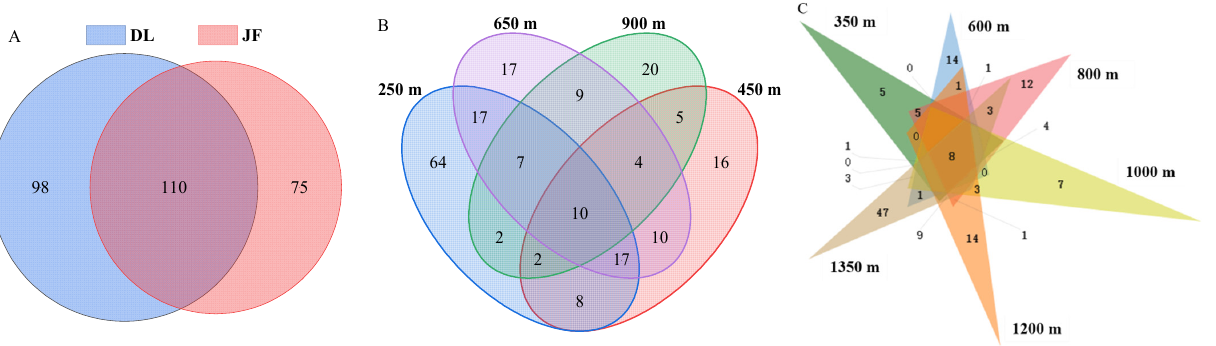
Figure 1. Venn diagrams showing the shared AMF OTUs between the two mountains ( A ) and at different altitudes on Mt. Diaoluo ( B ) and Mt. Jianfengling ( C ). Different colors represent different altitudes.